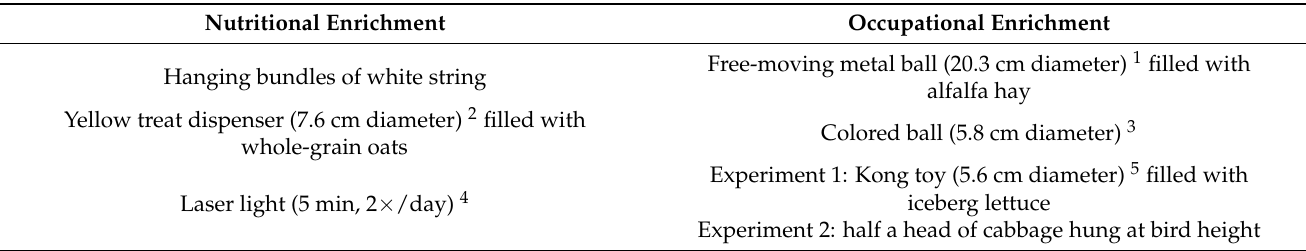
Table 1. Pairs of enrichment objects rotated every 3 days in high-complexity pens. Nutritional Enrichment